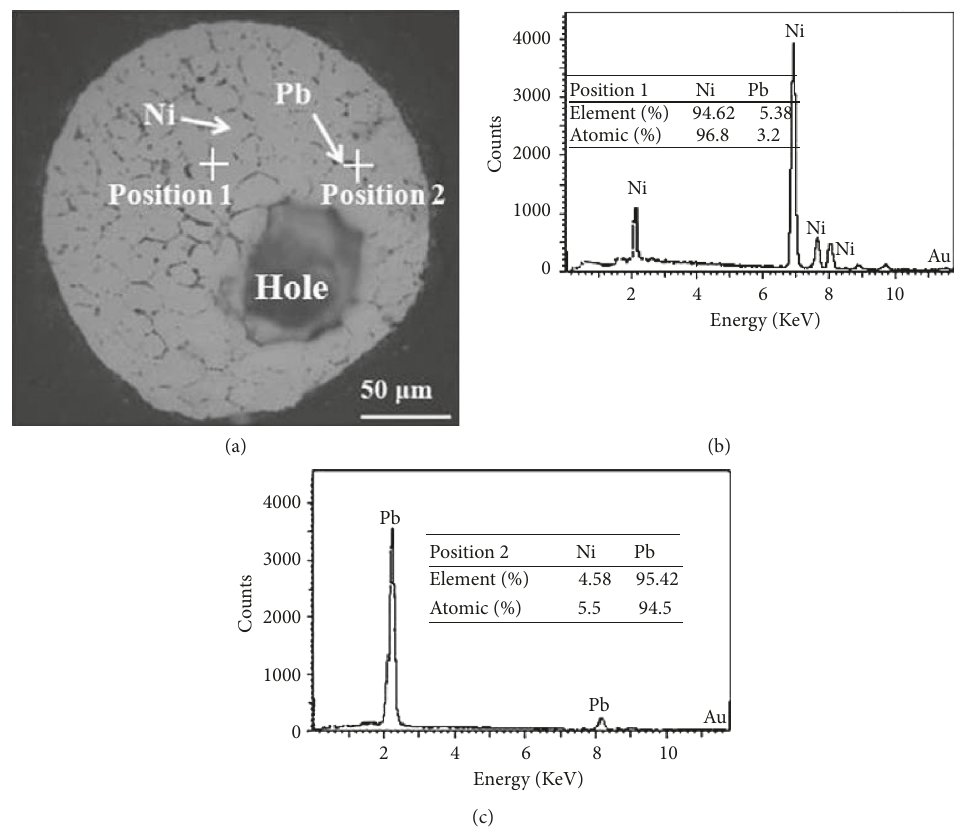
Figure 3: Microstructure and EDS spectrum of Ni-5% Pb alloy hollow particles at 50m/s: (a) the microstructure; (b) the EDS spectrum of position 1; (c) the EDS spectrum of position 2.